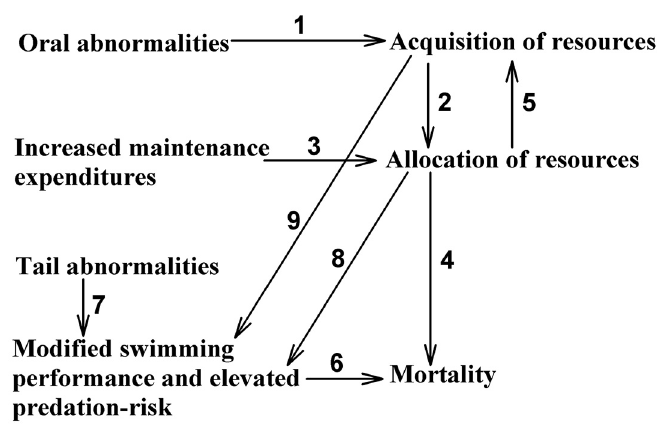
FIGURE 1. A diagram summarizing interactions among measured responses and their potential ramifications for larval bullfrogs inhabiting a coal ash–polluted site. Numbered arrows refer to the following measured or hypothesized relationships: 1 = limited ability of individuals with oral malformations to consume periphyton; 2 = decreased energy for allocation to various processes due to limited intake of resources; 3 = modified energy allocation patterns due to high expenditures of energy on maintenance; 4 = mortality resulting from failure to meet maintenance costs; 5 = limited ability to find and procure resources due to limited energy available for foraging activity; 6 = mortality resulting from decreased predator recognition and escape ability; 7 = decreased swimming speed in tadpoles with tail abnormalities; 8 = decreased swimming performance due to limited energy available; 9 = modified foraging behavior in individuals having oral abnormalities resulting from increased search time or area to locate alternative consumable